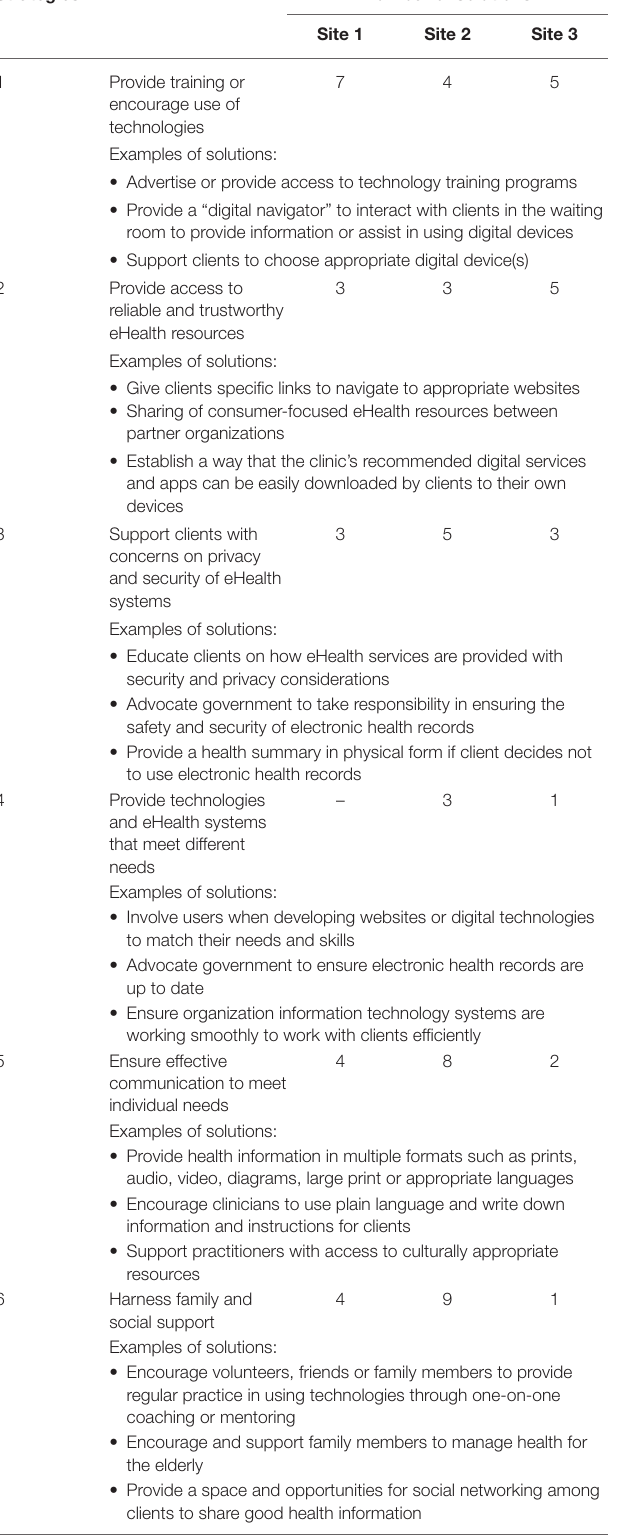
TABLE 7 | Co-designed strategies and number of solutions. Strategies Number of